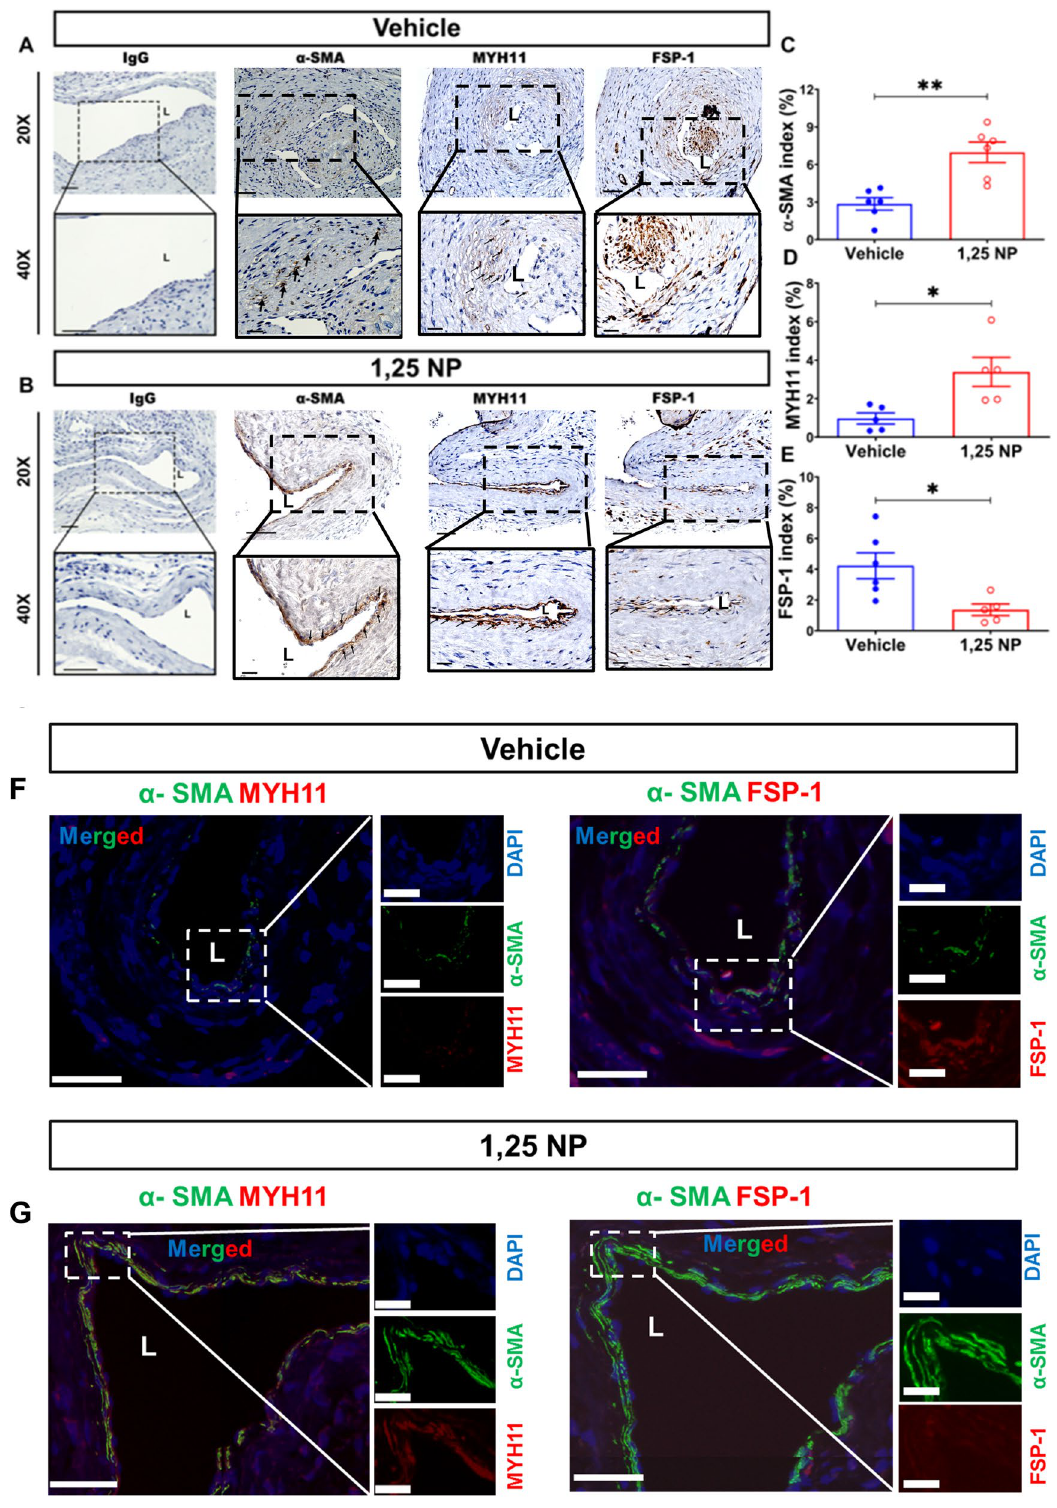
Figure 4. α-SMA, MYH11, and FSP-1 staining in 1,25 NP treated vessels. ( A and B ) Representative images for negative control (IgG), α-SMA, MYH11, and FSP-1 staining are shown in vehicle controls and 1,25 NP treated vessels. ( C – E ) Semiquantitative analysis showed a significant increase in the average α-SMA ( p < 0.05), MYH11 ( p < 0.05), but decrease in FSP-1 ( p < 0.05) indices in 1,25 NP treated vessels compared to vehicle controls, respectively. ( F , G ) Co-staining of α-SMA (+)/ MYH11 (+) and FSP-1 (+)/MHY11 (+) staining was performed in both groups at day 21. There are more α-SMA (+)/MYH11 (+) cells in 1,25 NP vessels compared to vehicle controls. Each data point in the scatter plot bar graph represents the mean ± SEM of 5–6 AVF mice. Unpaired t- test was performed. Significant differences are indicated * p < 0.05. ( A , B ) Cells staining positive for α-SMA, MYH11 and FSP-1 are brown staining. ( F , G ) Green color indicates positive α-SMA staining. Red color indicates MYH11 or FSP-1 positive staining. Blue color indicates positive staining for nuclei. ADV adventitia, L lumen; solid arrows, positive cells; dashed red line, positive stained area. Scale bar is 50